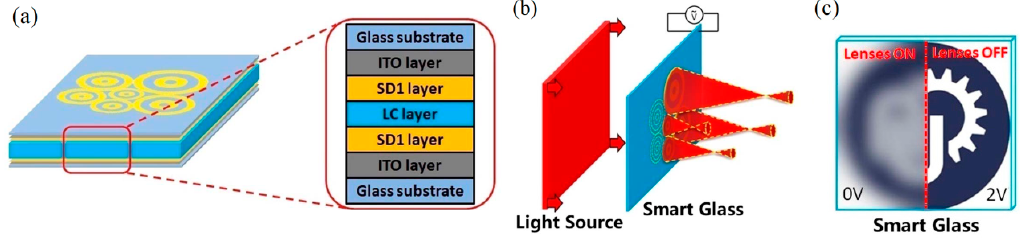
Figure 6. The operating principle of smart glass. ( a ) Smart glass configuration with the LC Fresnel lenses with different focal lengths. ( b ) Schematic representation of LC smart glass operating principle with several LC Fresnel lenses in ON- and OFF-states. ( c ) Paper printed school logo image. Blurry region corresponds to the ON-state of the smart glass; when the lenses are in the OFF-state, a clear image is observed.